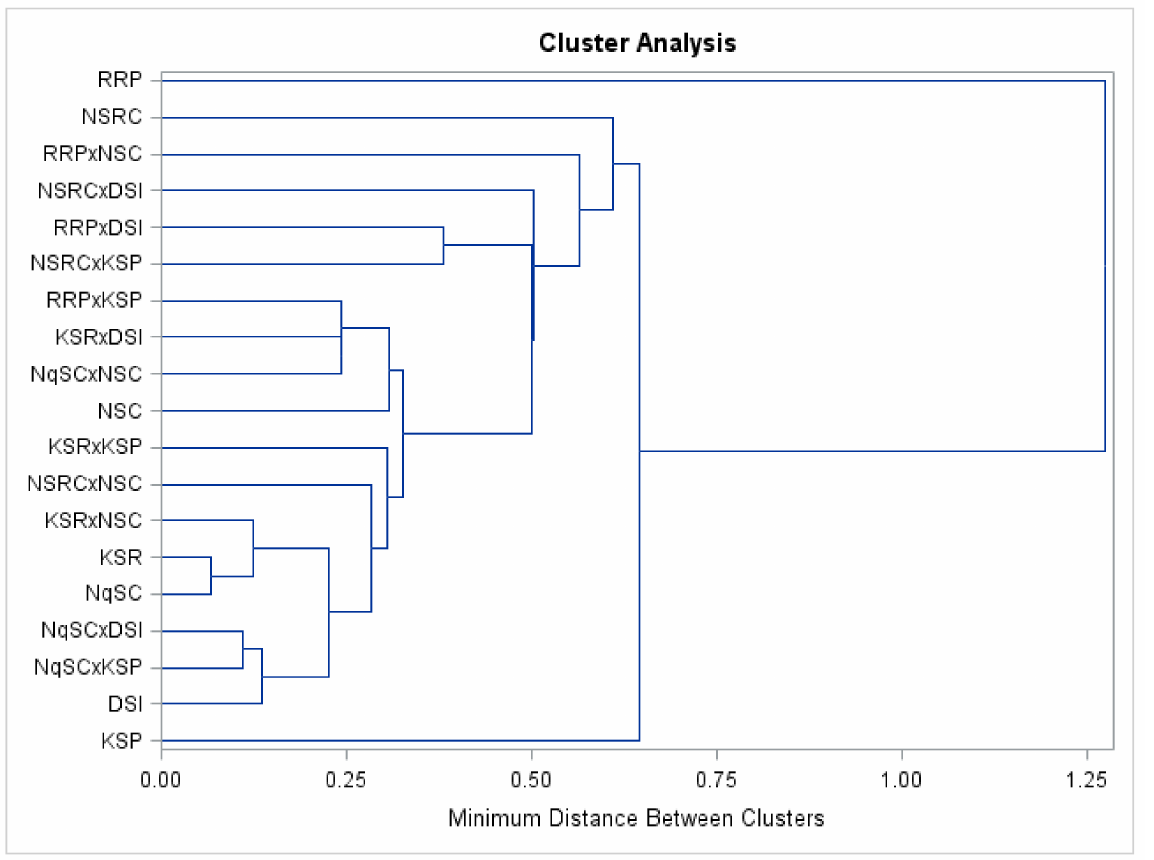
Figure 5. Hierarchical cluster showing similarities amongst Lagenaria siceraria genotypes using the complete linkage method. The description of genotypes appears in Table 2.